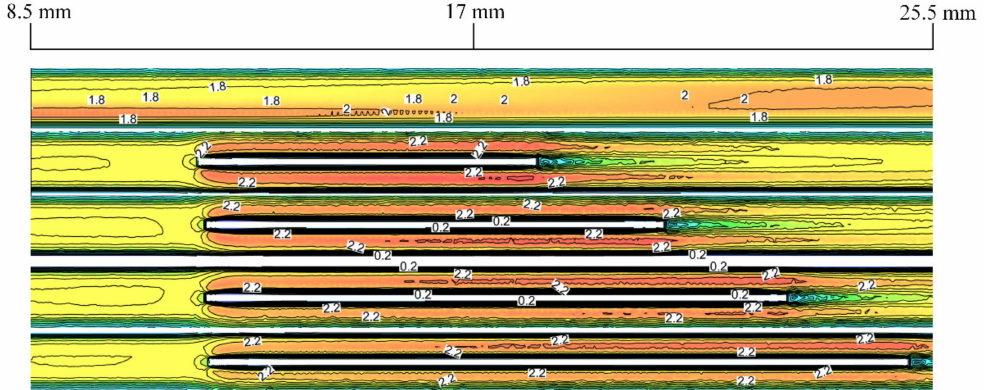
Figure 7. Velocity diagram of Cases 0–4 at the inlet velocity of 1.5 m/s.